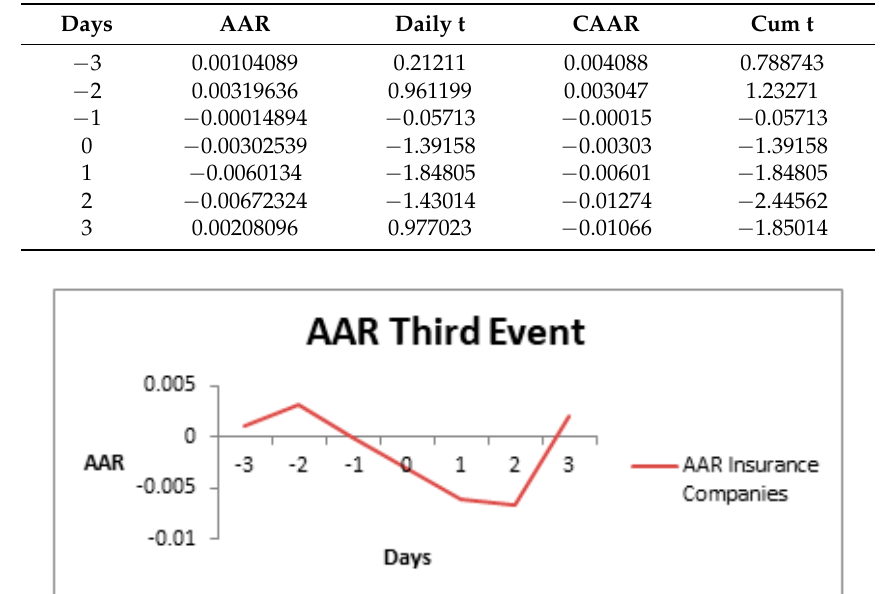
Table 8. Event study result of insurance companies for the third event. Source: Authors’ work.